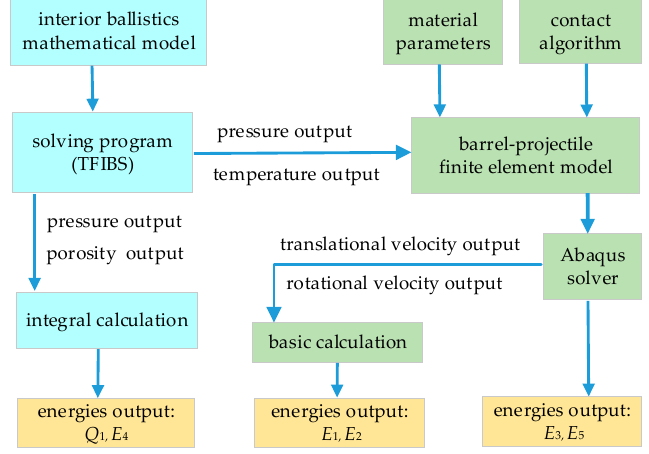
Figure 3. Flow chart of energies calculation.